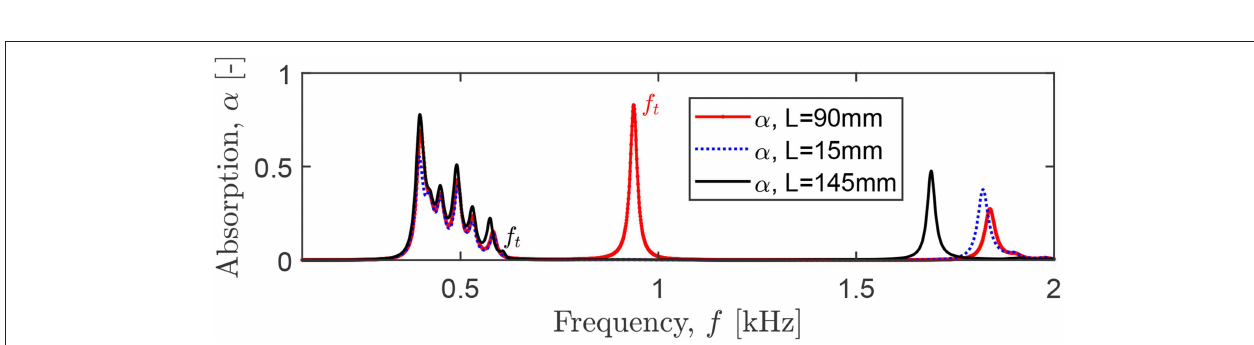
FIGURE 6 | The absorption of a panel with folded HRs (with an identical z coordinate) placed close to an open end of the tube of varying length L . The f t indicates the cavity resonance at c 0 / 4 L .